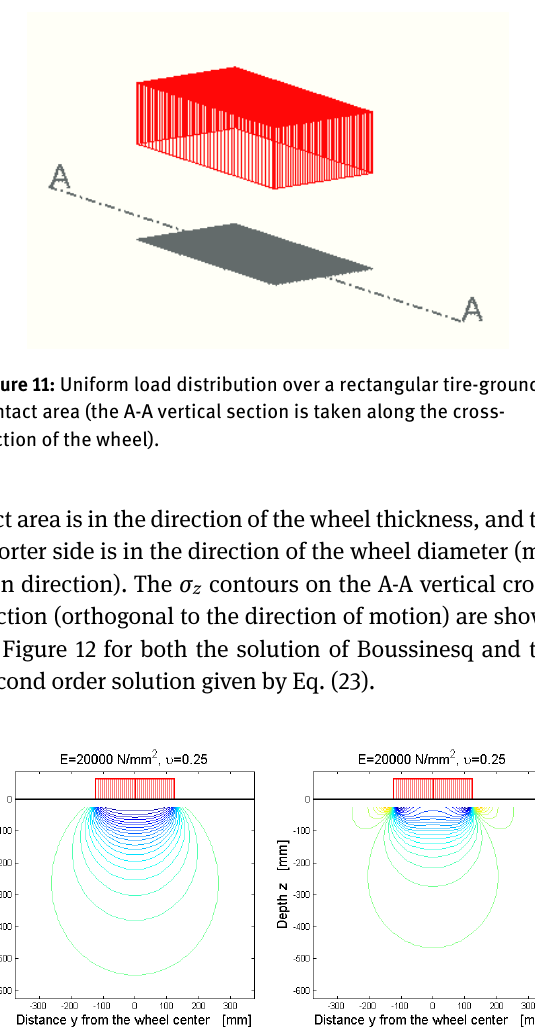
Figure 12: σ z contours on the A-A vertical cross-section of Figure 11: Boussinesq’s solution on the left and the second order solution on the right.